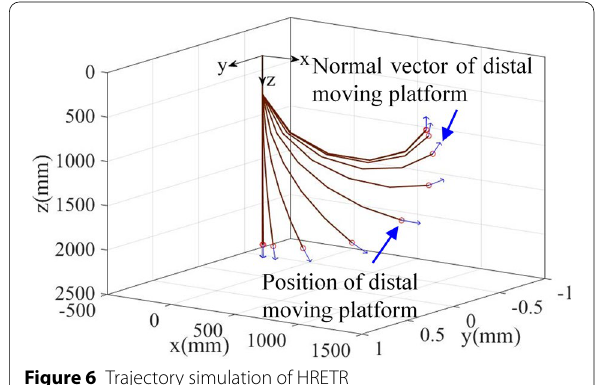
Figure 6 Trajectory simulation of HRETR